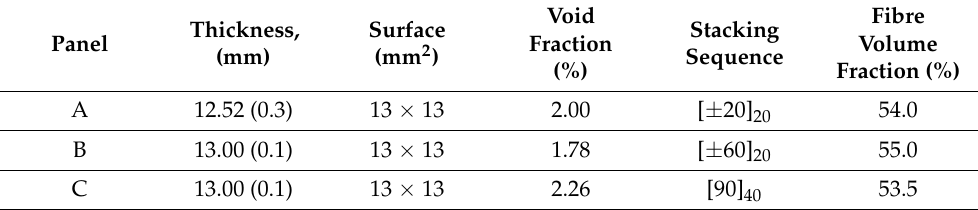
Table 1. Characteristics of the composite